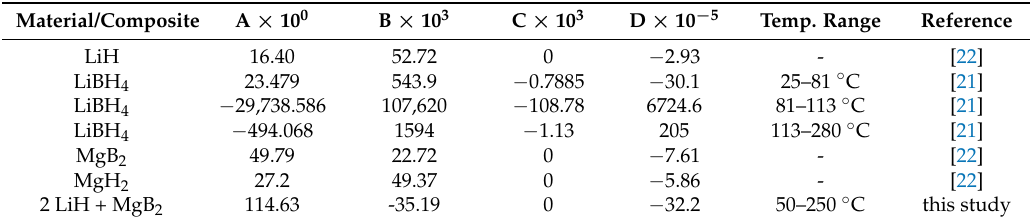
Table 1. Parameters for the polynomial fit, according to Equation (8), of c p (in J K − 1 mol − 1 ) for different